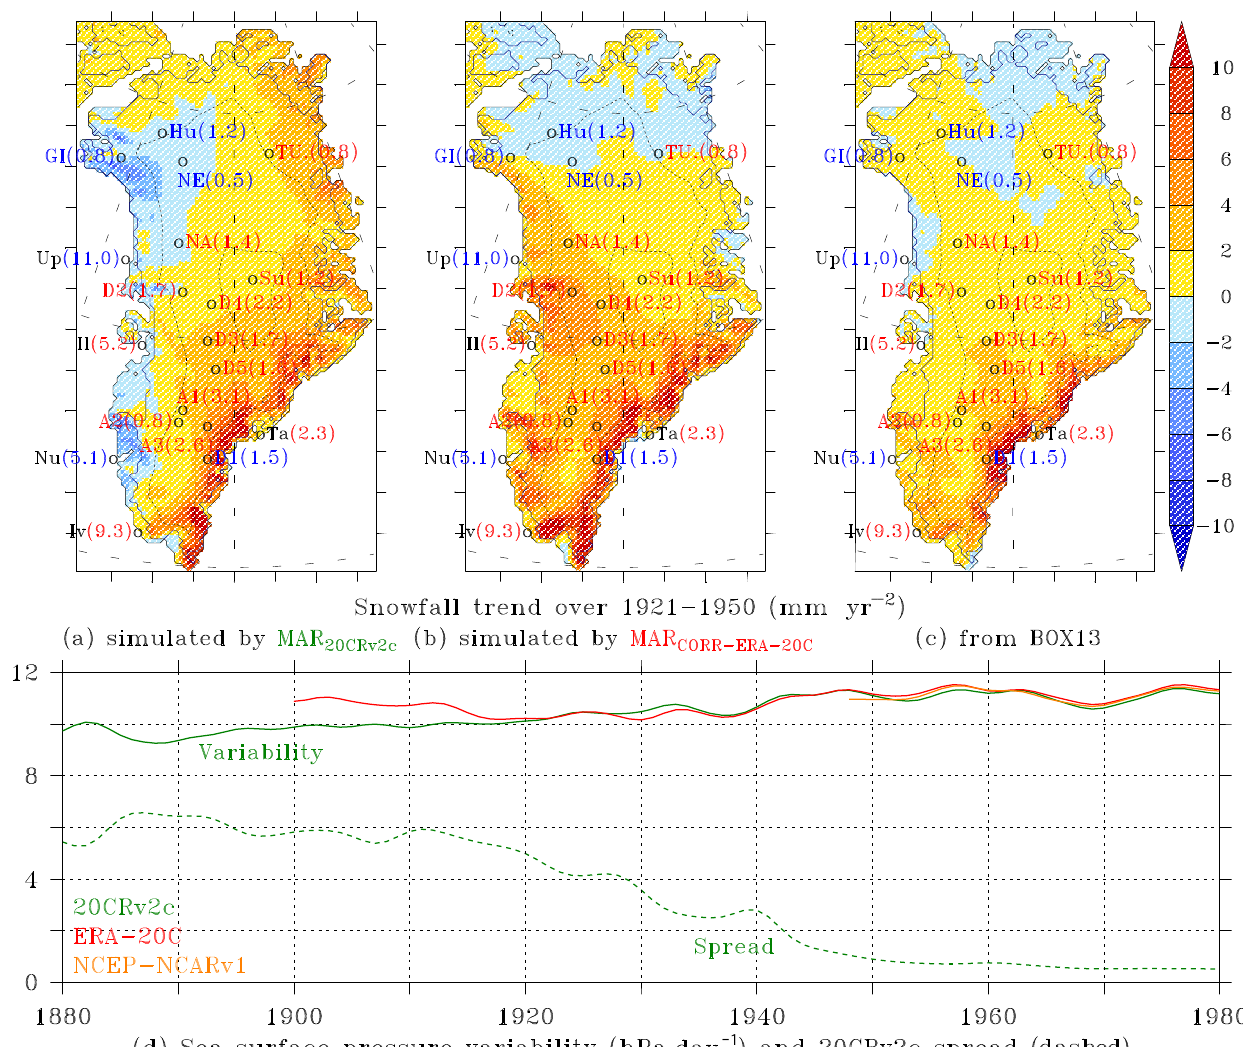
Figure 9. (a) Annual snowfall trend (in mm.w.e.yr − 2 ) over 1921–1950 as simulated by MAR forced by 20CRv2c. The observed trend (in mm.w.e.yr − 2 ) from some locations listed in Mernild et al. (2015) are also highlighted on the figure. These observed negative (positive) trends are the values printed in blue (in red) on the map. Trends of total precipitation (rain + snow) are also labelled in black for five coastal weather stations from DMI. (b) Same as (a) but for MAR CORR − ERA − 20c . (c) Same as (a) but for BOX13. (d) Time series of the annual mean daily variability (i.e. standard deviation of the daily values) of the sea level pressure around Greenland (0 ◦ W ≤ longitude ≤ 80 ◦ W and 55 ◦ N ≤ latitude ≤ 85 ◦ N) from 20CRv2c (in green), ERA-20C (in red) and NCEPv1 (in orange). The ensemble mean spread (i.e. the standard deviation of the ensemble deviations at each time) from 20CRv2c over the same area is also plotted with dashes. Finally, only 10-year running means are shown for more